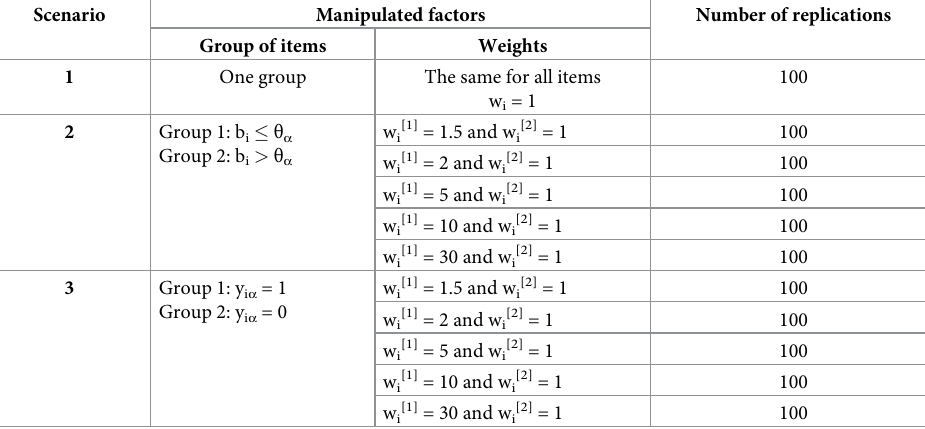
Table 1. Summary of the proposed